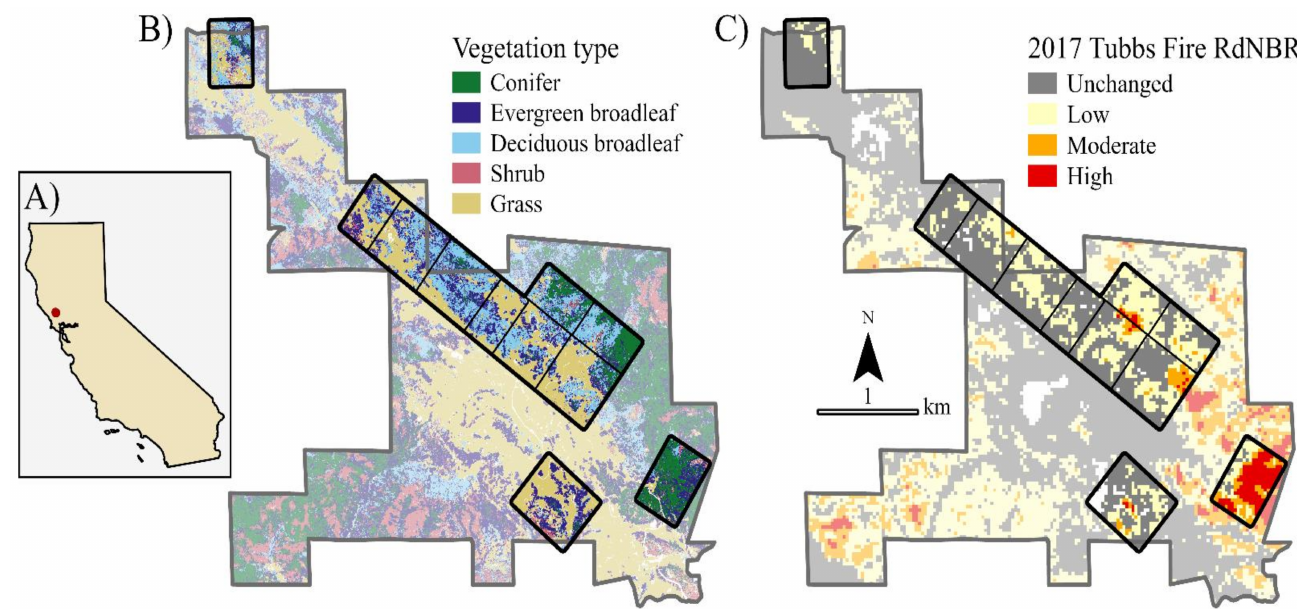
Figure 1. ( A ) Study site location at Pepperwood Preserve (red point) in California, USA. Maps of ( B ) vegetation assemblages and ( C ) the 2017 Tubbs Fire burn severity (MTBS) across the study site. Unoccupied aerial systems structure from motion (UAS-SfM) data collection extent is represented by black